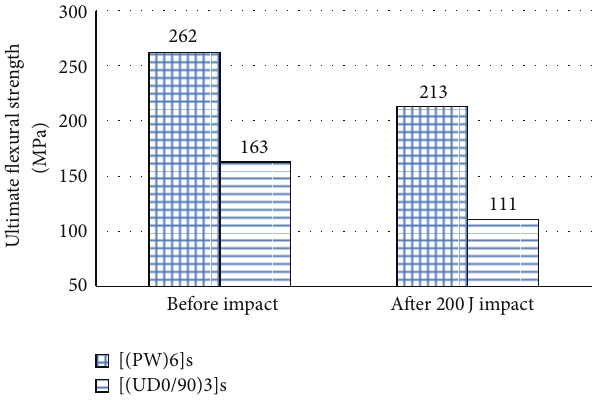
Figure 8: Ultimate flexural strength comparisons before and after impact tests on UD and PW